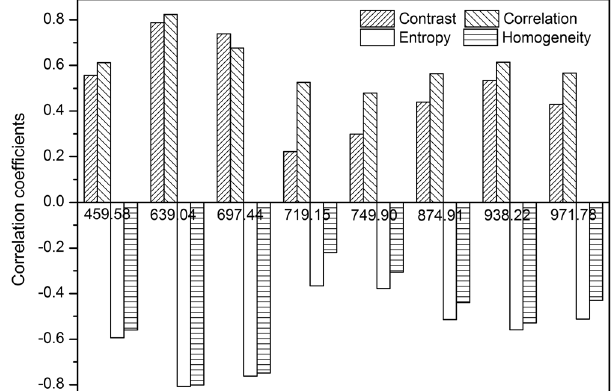
Figure 3. Correlation coefficients between reference values of disease degree and texture variables from effective